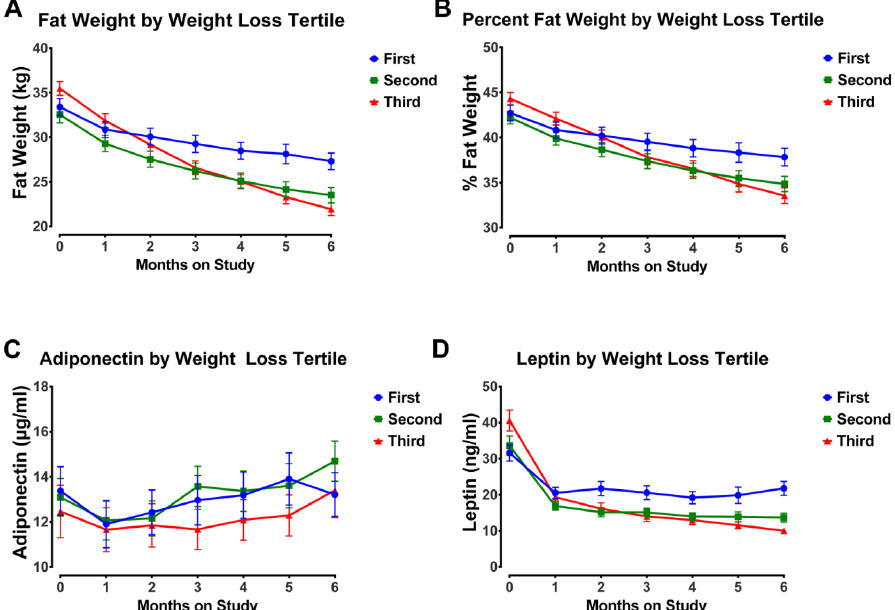
Figure 3. Body fat mass and plasma adipokines by weight loss tertile. The subset of individuals who lost at least 5% of initial body weight (92% of all individuals who completed the study) were divided into tertiles of weight loss, which corresponded to >5%, tertile 1; >10%, tertile 2; and >15%, tertile 3 of initial body weight. ( a ) Fat mass in kg over successive months of the weight loss intervention. ( b ) Body fat expressed as a (%) over successive months of the weight loss intervention. ( c ) Adiponectin ( μ g/mL) over successive months of the weight loss intervention. ( d ) Leptin (ng/mL) over successive months of the weight loss intervention. Values are means ± SEM. With weight loss >10%, leptin decreased progressively over time, and the decrease was significant with weight loss >15% ( p = 0.007); whereas, there was no significant effect of weight loss magnitude on circulating levels of